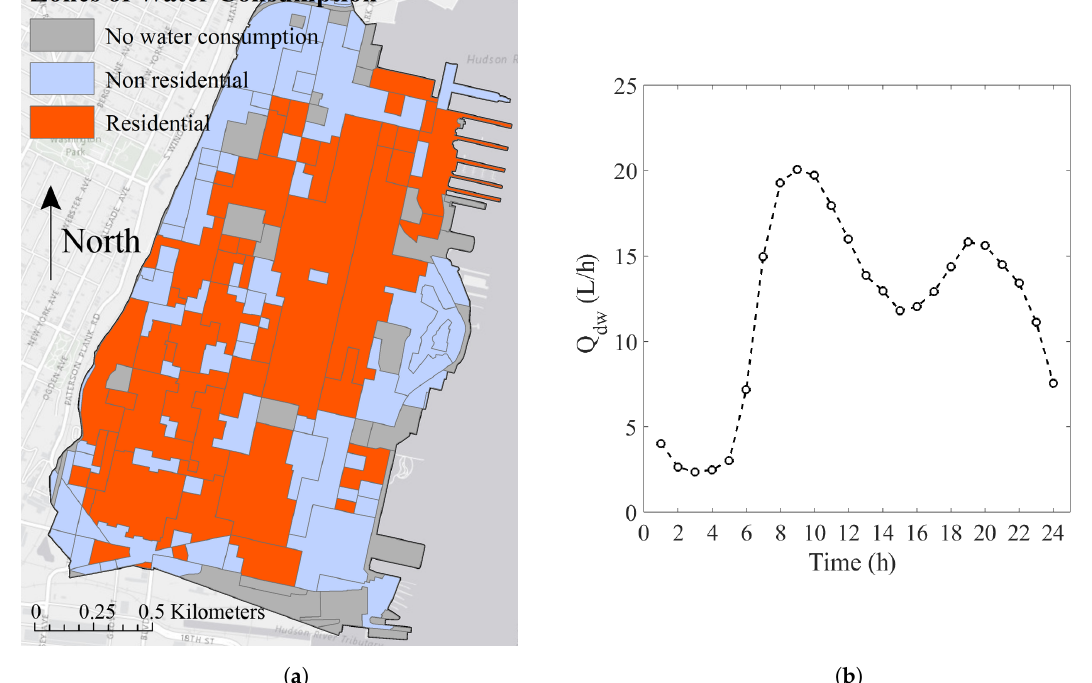
Figure 5. Information required for dry-weather flow calculations: ( a ) distribution of the land use; and ( b ) daily residential water discharge per